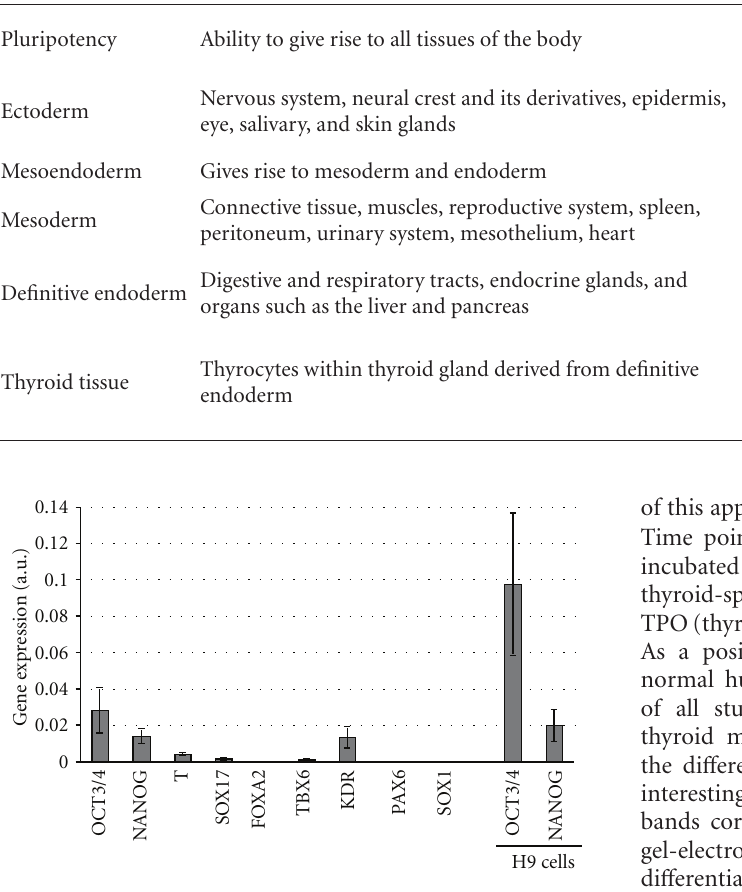
Figure 3: Expression of pluripotency and early di ff erentiation mRNA markers in EBs and pluripotency markers in H9 hESCs on the right. Detailed marker description is presented in Table